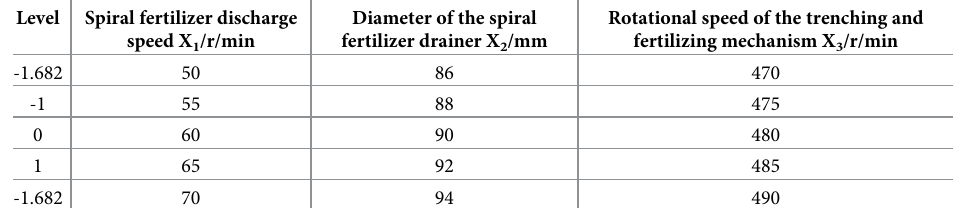
Table 3. Test factors and levels. Level Spiral fertilizer discharge speed X 1 /r/min